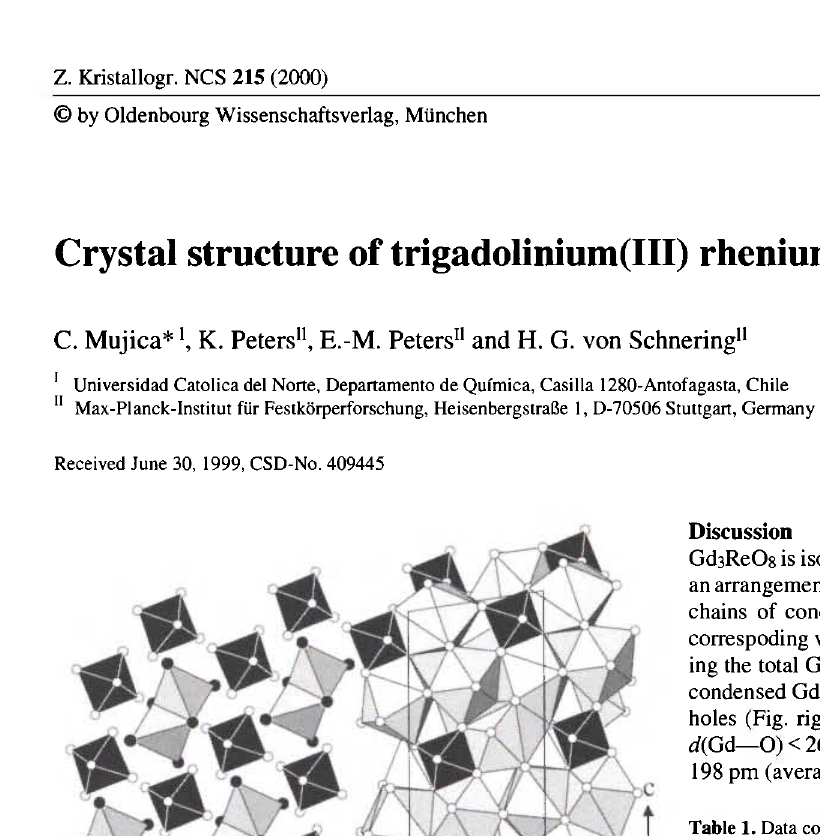
Table 1. Data collection and